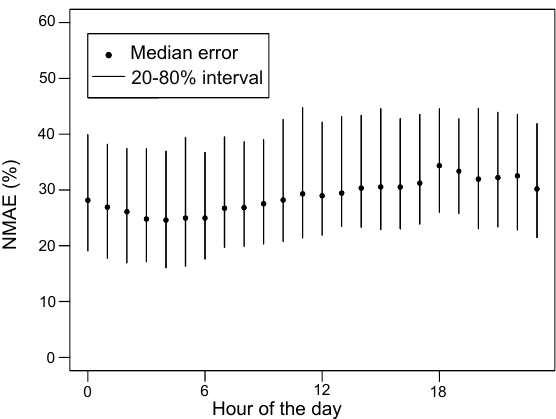
Figure 4. Hourly errors distribution (NMAE in % on the y -axis) depending on the hour of the day ( x -axis). We then represent the NMAE, averaged over the 24 h, as a function of the thermal sensitivity in Figure 5.